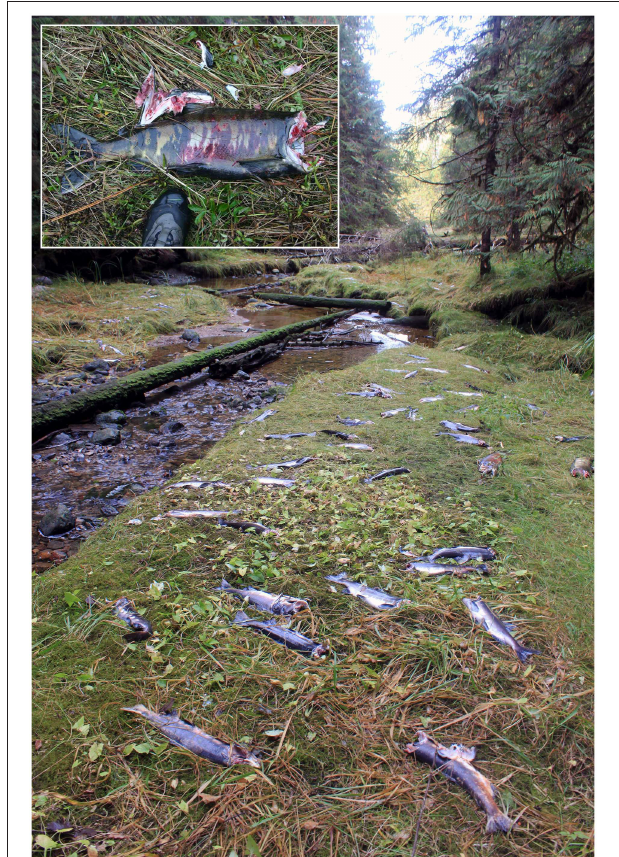
FIGURE 2 | Wolf-transferred salmon carcasses with missing heads and minimal damage to body and trunk; no other parts of body consumed. Photo credit: Morgan Hocking (main), John Reynolds